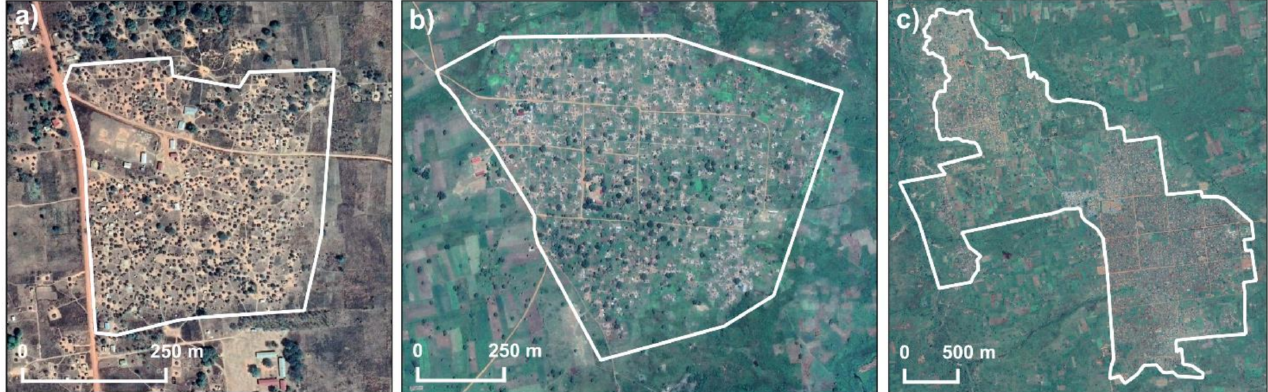
Figure 3. Refugee settlement boundaries established by UNHCR (white outline) at ( a ) Mireyi, ( b ) Boroli I and ( c ) Ayilo I. Background imagery based on Google Maps-hosted CNES/Airbus images from